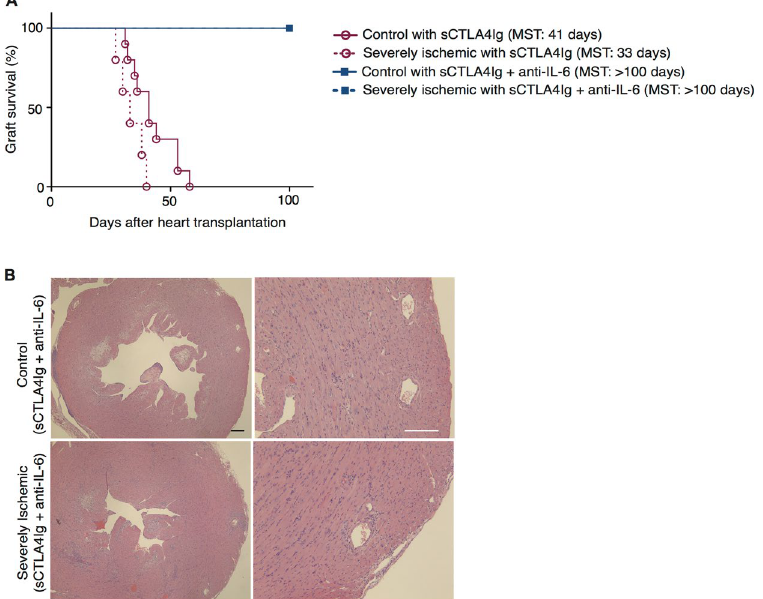
Figure 6. Anti-IL-6 synergizes with CTLA4Ig to improve graft outcomes, even under severe IRI conditions. BALB/c hearts were harvested and transplanted into full MHC mismatched C57BL/6 recipients within 30 minutes (control) or after 16 hours (severely ischemic). All recipients were treated with single dose of CTLA4Ig on day 2 (sCTLA4Ig). Anti-IL-6 was given as described, until day 13. ( A ) Despite treatment with sCTLA4Ig, severely ischemic grafts underwent accelerated rejection compared to control. Addition of anti-IL-6 to sCTLA4Ig treatment overcame the effect of severe ischemia, and both control and severely ischemic grafts survived for more than 100 days. ( B ) Histology at 100 days post-transplant of control and severely ischemic BALB/c heart grafts into C57BL/6 recipients and treated with sCTLA4Ig and anti-IL-6. Both control and severely ischemic grafts showed only minimal lymphocyte infiltration and little vasculopathy. (Scale bar 100 μ